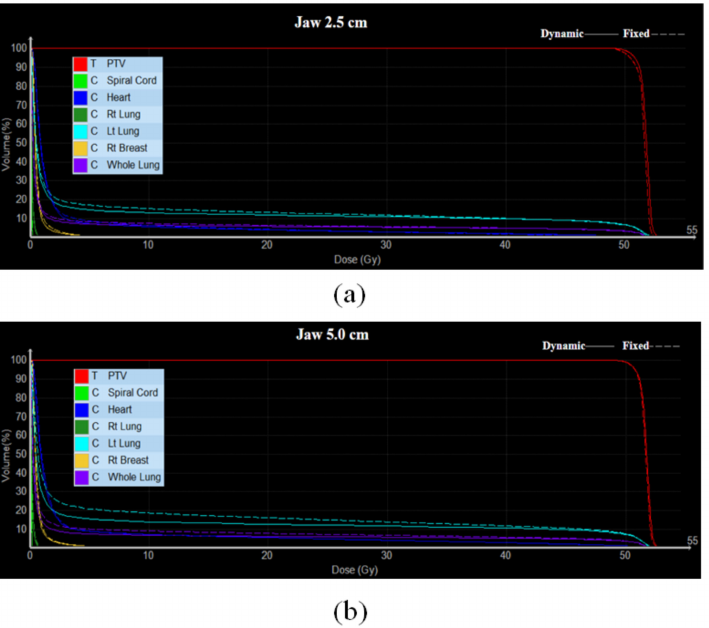
Figure 4. DVH comparison between fixed and dynamic modes with field width of ( a ) 2.5 cm and ( b ) 5.0 cm for TD-3DCRT plans {RAO (310 ◦ ) and LPO (123 ◦ ) directions}. As regards the left lung, using a field width of 5 cm produced a larger dosimetric difference between the fixed and dynamic jaw modes than a field width of 2.5